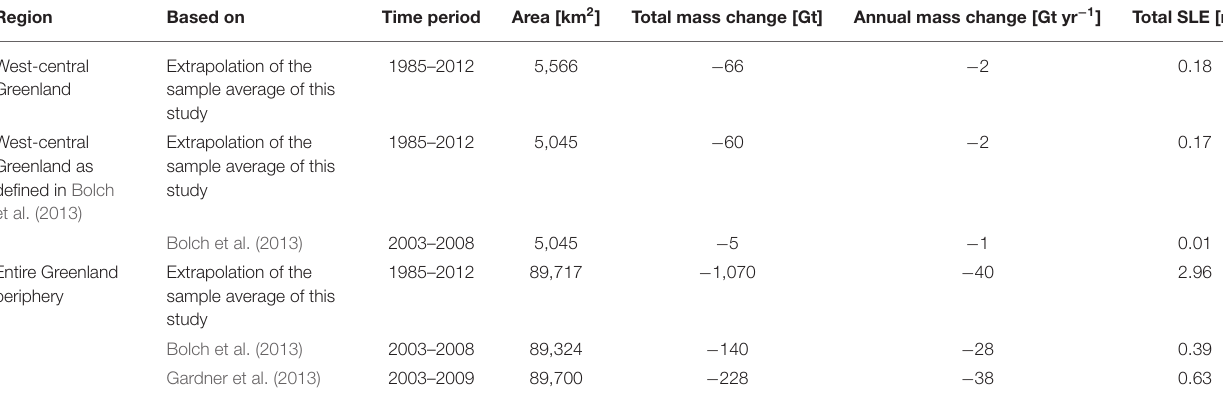
TABLE 3 | Regional glacier mass changes for Greenland. Region Based